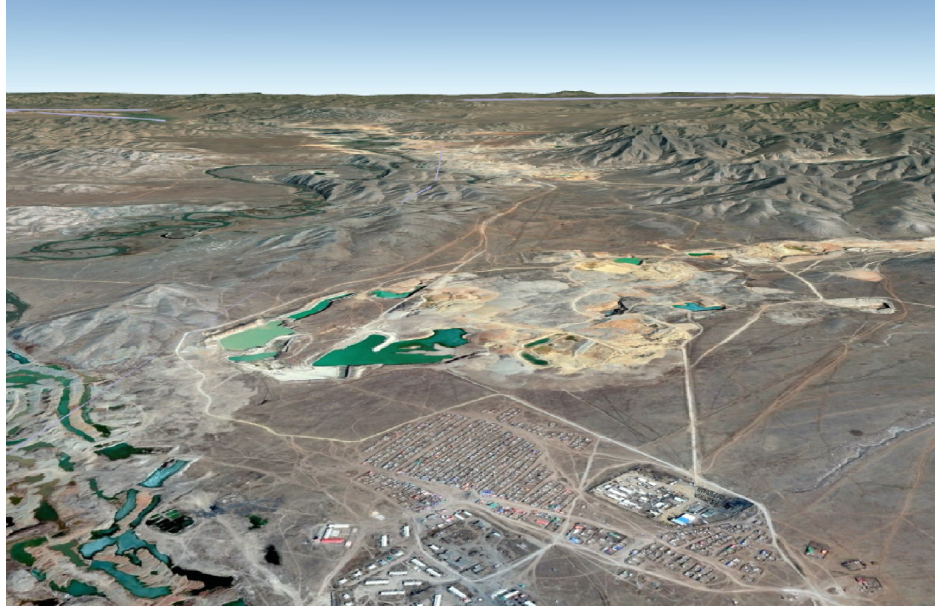
Figure 6. Mining exploration in Zaamar